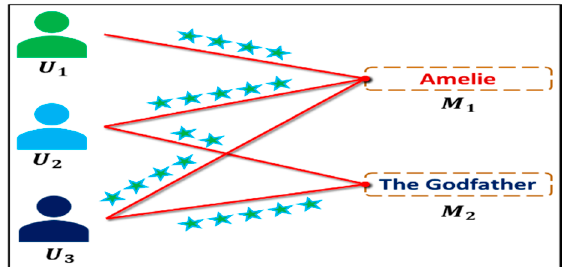
Figure 44. An affiliation network as a bipartite graph between three users ( U 1 , U 2 , U 3 ) and two movies